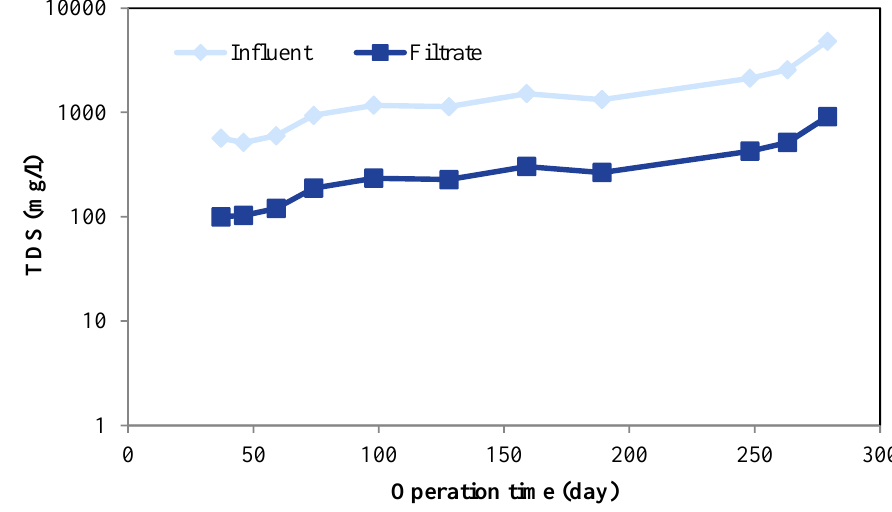
Figure 5. Total dissolved solids (TDS) concentrations during process operation TDS: Total dissolved